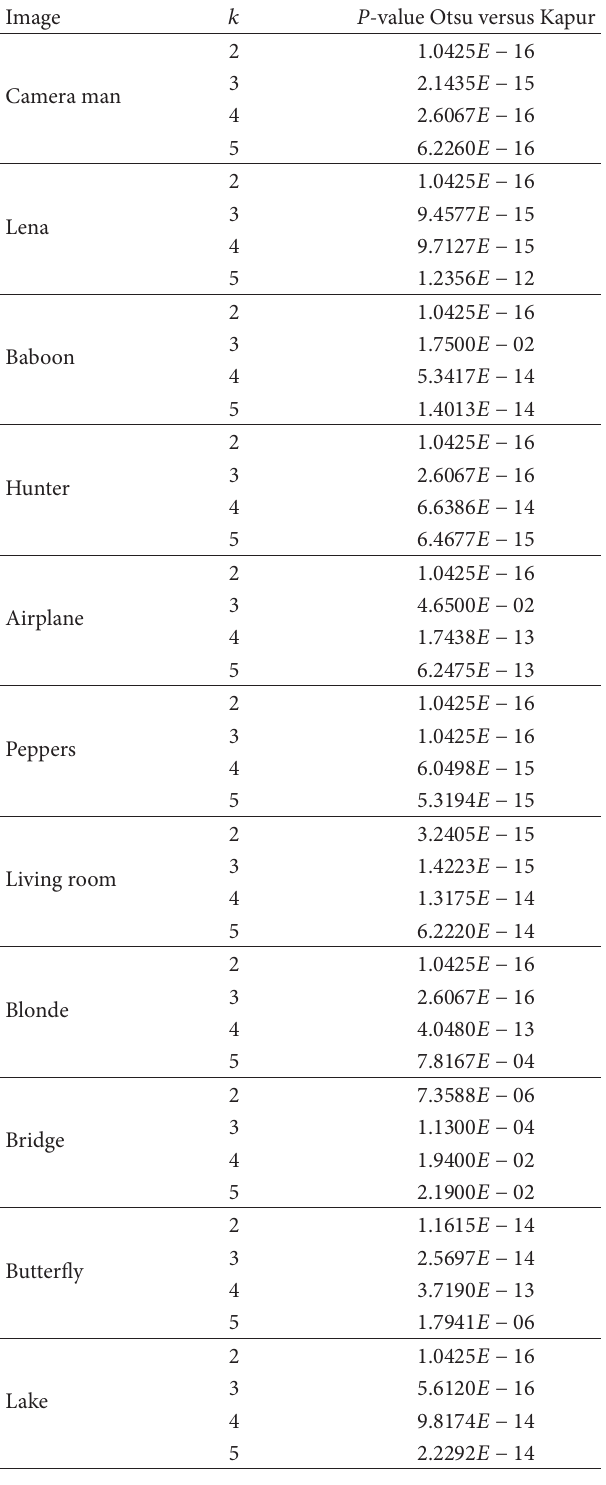
Table 15: 𝑃 values produced by Wilcoxon’s test comparing Otsu versus Kapur over the averaged PSNR from Tables 3 and